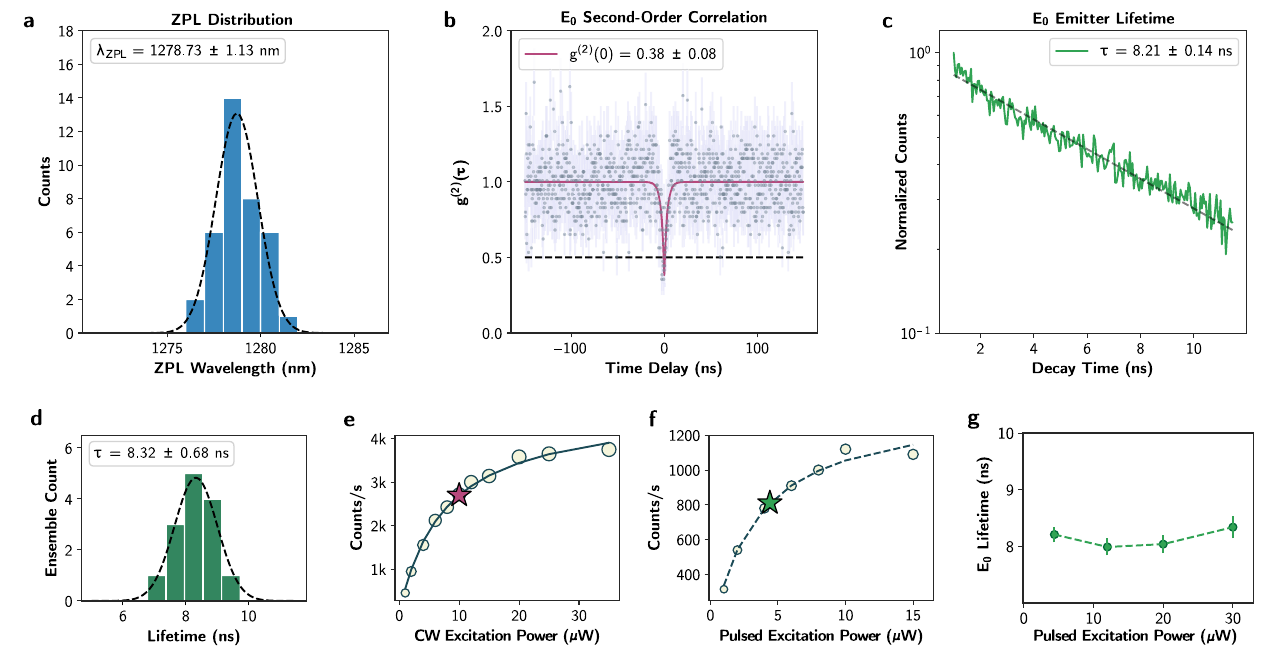
Fig. 3 | Isolation of single emitters and statistics. a ZPL distribution of 37 waveguide-coupledG-centers. b Second-orderautocorrelationmeasurementfor E 0 shows g (2) (0)<0.5 and single photon emission for a continuous-wave excitation power of 10 μ W, corresponding to an estimated power density of 5.4kWcm − 2 . Poissonian error bars are included for each sample point, and error in the g (2) (0) is the error of the fi t. c Lifetime of emitter E 0 and d statistics for 13 G-